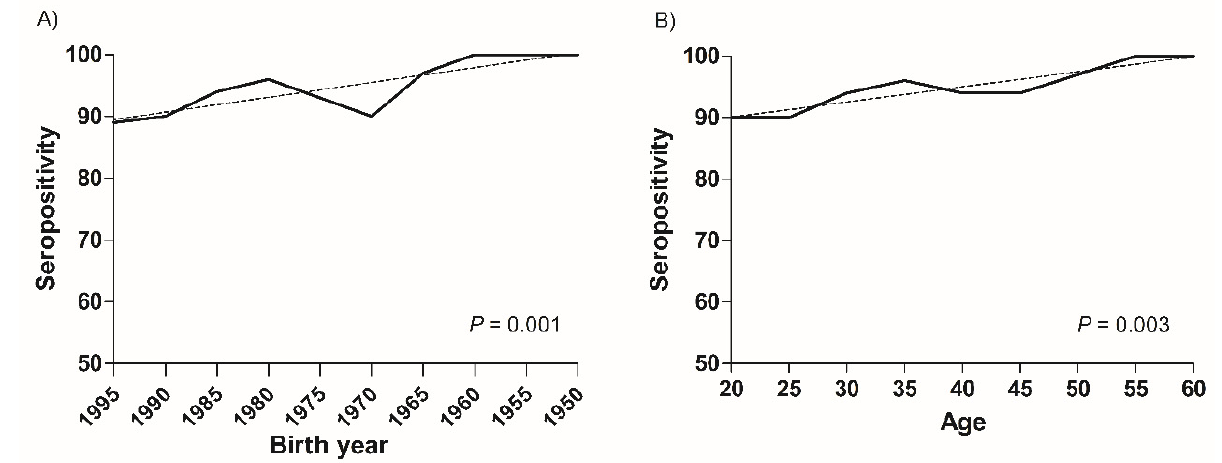
Figure 1. Changes of seroprevalence of varicella-zoster virus in healthcare workers according to birth year and age groups. The seroprevalence of varicella-zoster virus in healthcare workers significantly decreased according to ( A ) the birth year groups ( p = 0.001) and ( B ) the age groups ( p = 0.003).